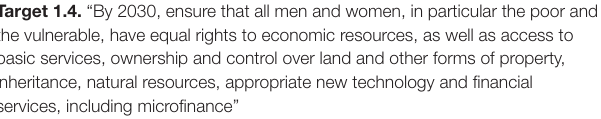
TABLE 1 | Sustainable Development Goal (SDG) targets, endorsed by the United Nations (UN), relevant to adopting RNAi crop technology in developing countries. Target 1.4. “By 2030, ensure that all men and women, in particular the poor and the vulnerable, have equal rights to economic resources, as well as access to basic services, ownership and control over land and other forms of property, inheritance, natural resources, appropriate new technology and financial services, including